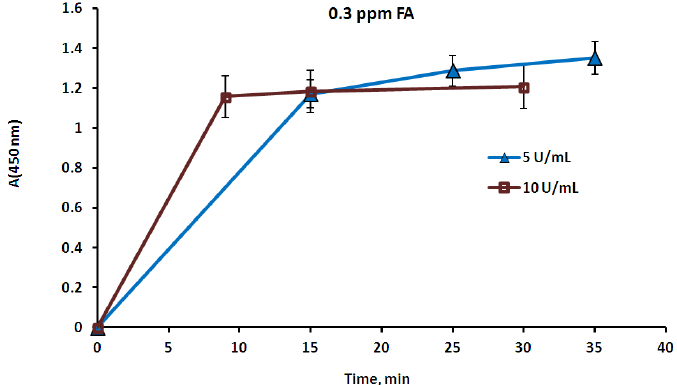
Figure 5. Color development in the membrane devices containing 3.5 mg·mL −1 of HRP, 2 mg·mL −1 of chromogen and 5 or 10 U·mL −1 of AOX. The devices were exposed to airborne FA at a concentration of 0.3 ppm, and the color intensity was measured at various time periods starting from the color development point.